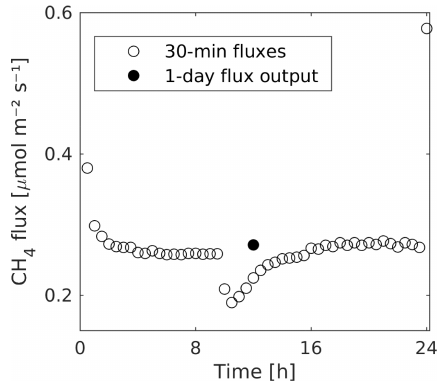
Figure 12. Daily CH 4 flux in the test comparing 30min and daily time